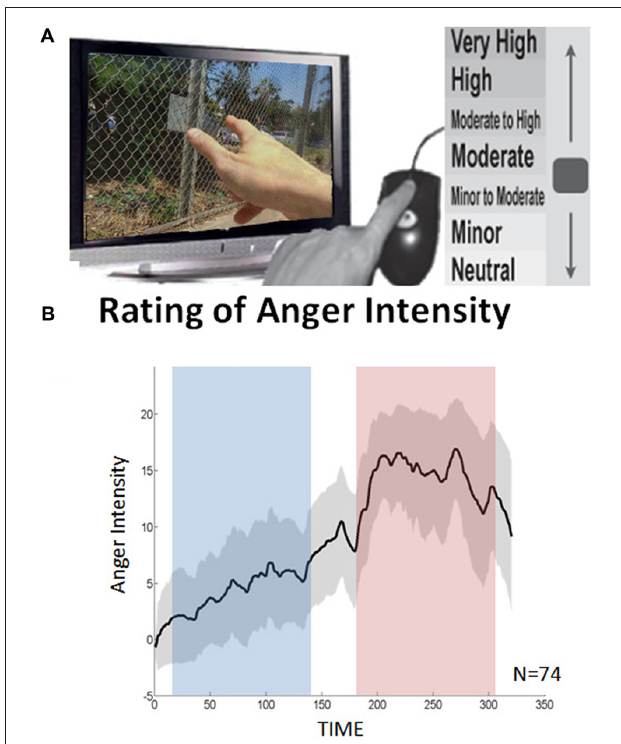
FIGURE 1 | Continuous anger intensity rating. (A) The participants retrospectively reported shifts in intensity of anger experienced while watching the clip. (B) The averaged continuous emotion rating over all 74 subjects. The dashed lines indicate the standard deviation. Using Wilcoxon signed rank test, a significant difference was found between the low and high anger conditions (blue and red rectangles respectively) in terms of reported anger intensity ( p < 5 × 10 − 14